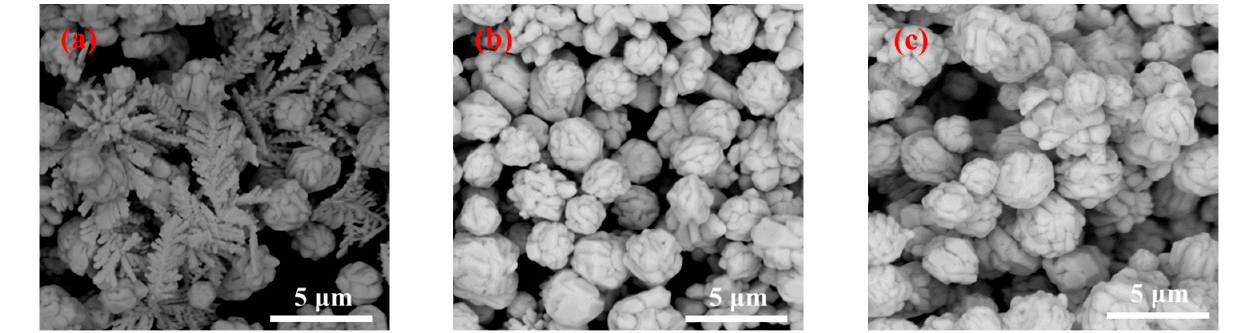
Figure 5. SEM images of the silver powder prepared under different flow rates by adding 1% gela- tin. ( a ) 50 mL/min; ( b ) 75 mL/min; and ( c ) 100 mL/min .